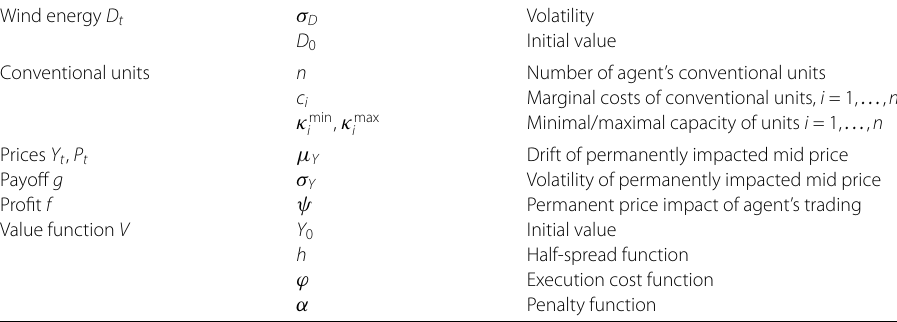
Table 2 Unit Parameters for the conventional units i = 1,2,3, n = 3 Marginal